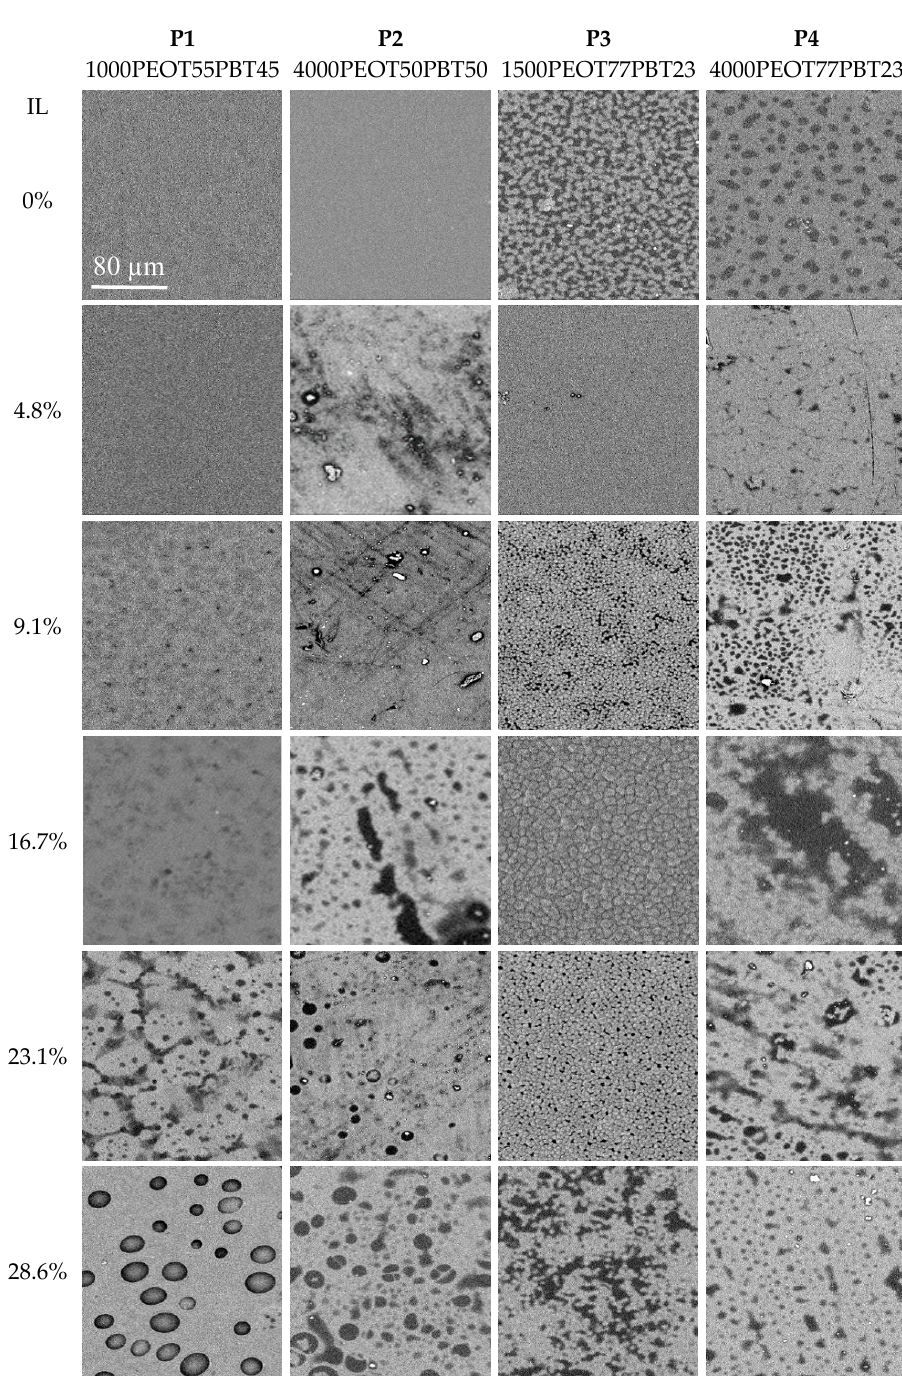
Figure 2. SEM images of the neat polymers (top line) and the polymers with increasing ionic liquid content with backscattering detection, highlighting the ordered crystal phases in the film. All images at magnification 1000×; the scale bar is the same for all samples.